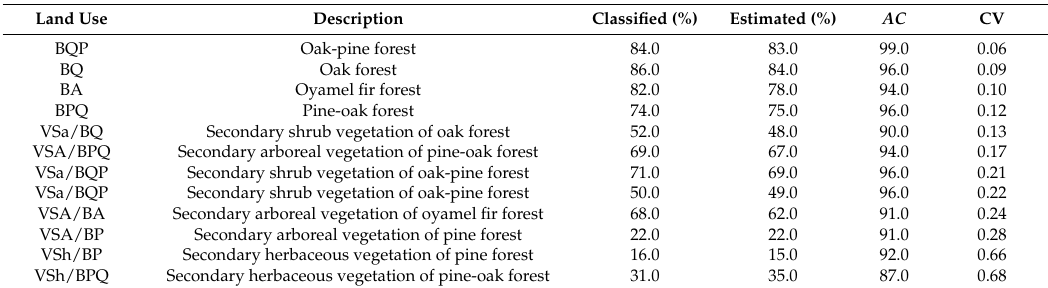
Table 2. Accuracy evaluation of the visual interpretation of the images in 12 zenith sampling plots (overstory cover).